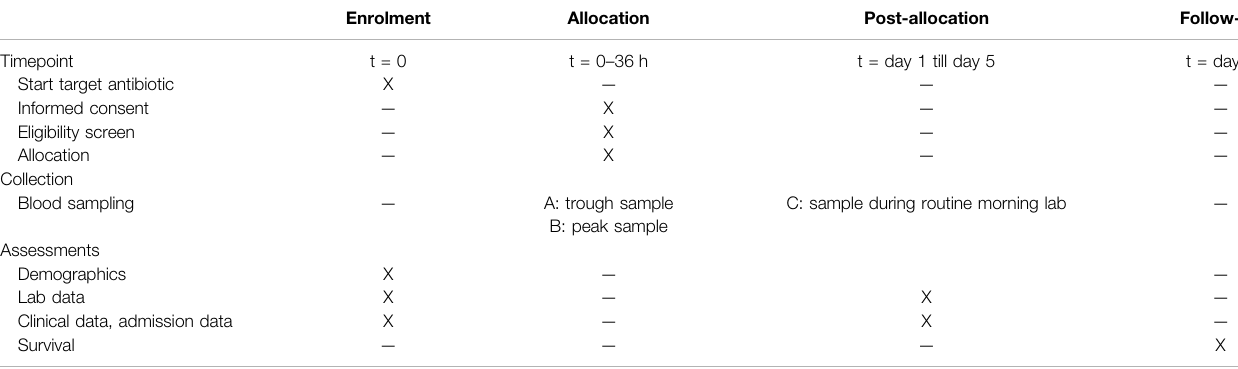
TABLE 1 | Study procedures timeline. Time path of enrolment, sampling, and assessments in the study. Enrolment